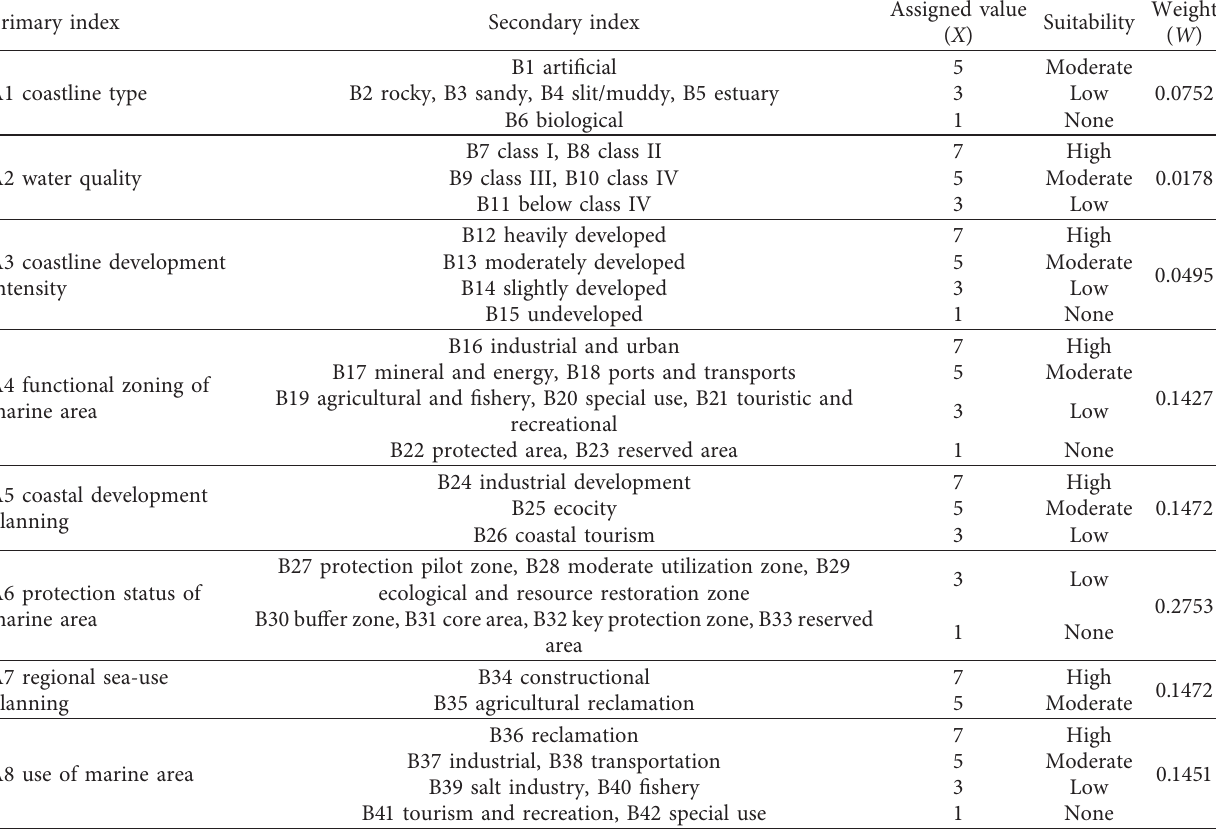
Table 1: Classification values and weights of the suitability indexes.